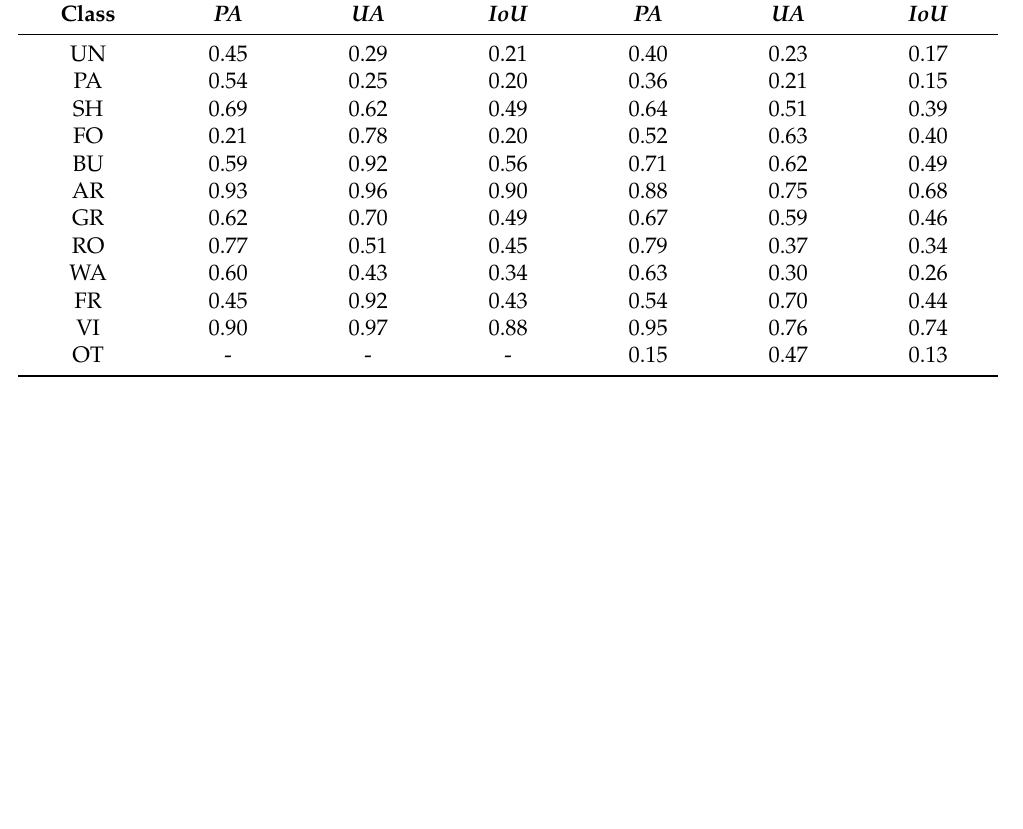
Figure 10. Loss function for the “Base” experiment with UNet for PNOA. Table 13. Class metrics for the experiment with UNet on UOPNOA. Experiment